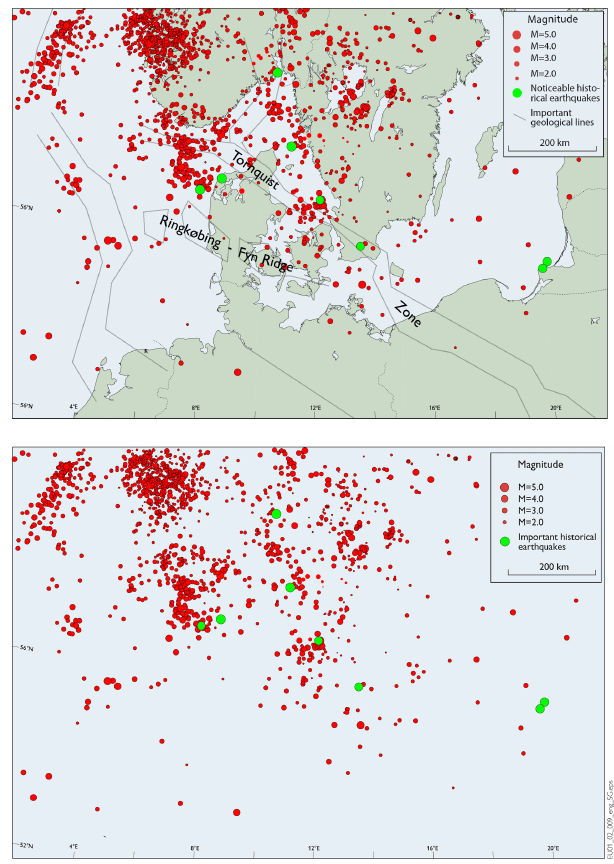
Fig. 2. Earthquake activity in and near Denmark without and with coast lines and geological zones. Red dots show modern well- located earthquakes of the last 75yr, and green dots show the most important relatively larger earthquakes in 1759, 1841, 1904, 1985, 2004, 2008, and 2010. The two maps cover the same area. Denmark is in the middle. Upper right hand corner is inside the Fennoscan- dian Shield, and in the lower left corner we are outside the shield. A gradual and irregular transition from the shield is noted. This can be termed the edge of the shield in relation to stresses and strains. From Gregersen et al. (2011).